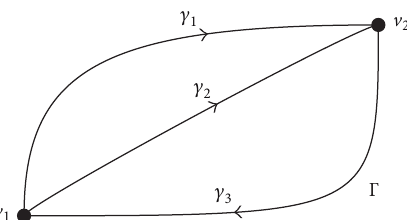
Figure 1: Closed graph Γ with three links and two vertices. Link 𝛾 𝑘 carrying a charge amounts to −𝑛 1 − 𝑛 2 + 𝑛 3 = 0 . Figure 2: Two charge network graphs with the singular point